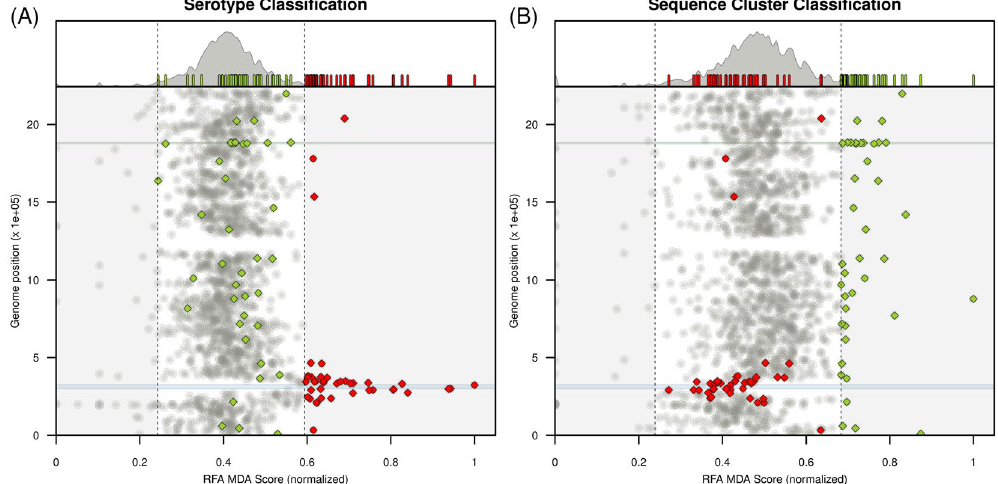
Figure 2. Random forest classification excluding data with gene mismatches. ( A ) Random forest analysis (RFA) for serotype classification when excluding genes for which the allelic notation process had < 99% positive matches with the reference genome. ( A , top) Density function of RFA scores obtained for each gene in the dataset. The 95% boundaries are marked by the dashed lines. Small bars highlight the RFA scores of genes within particular groups (red for serotype, green for SC genes). ( A , bottom ) Genomic position for each gene in the dataset against their RFA score (normalised to [0,1]). The circular genome is presented in a linear form on the y-axis, with the first gene being dnaA and the last gene parB . Red and green diamonds mark the top 2.5% ranking genes for serotype and Sequence Cluster classification, respectively. ( B ) RFA for Sequence Cluster classification; figure details the same as in A . Blue shaded areas in both A and B mark the capsular locus (genes within aliA and dexB ). Green shaded areas in both A and B mark the genes contiguous and including the groESL operon (Table